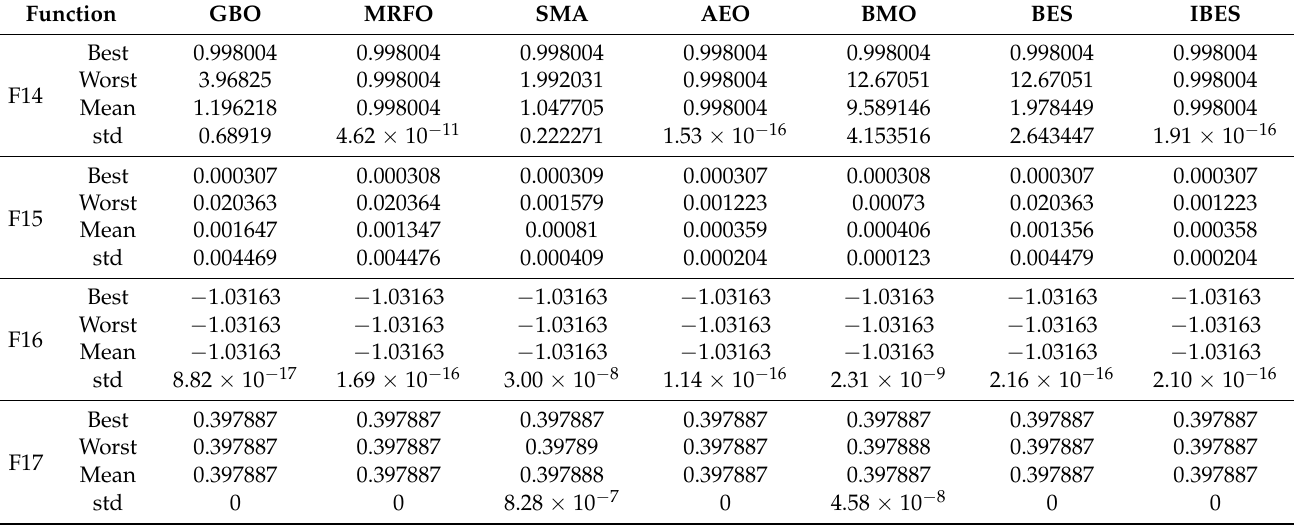
Table 4. Results for composite benchmark